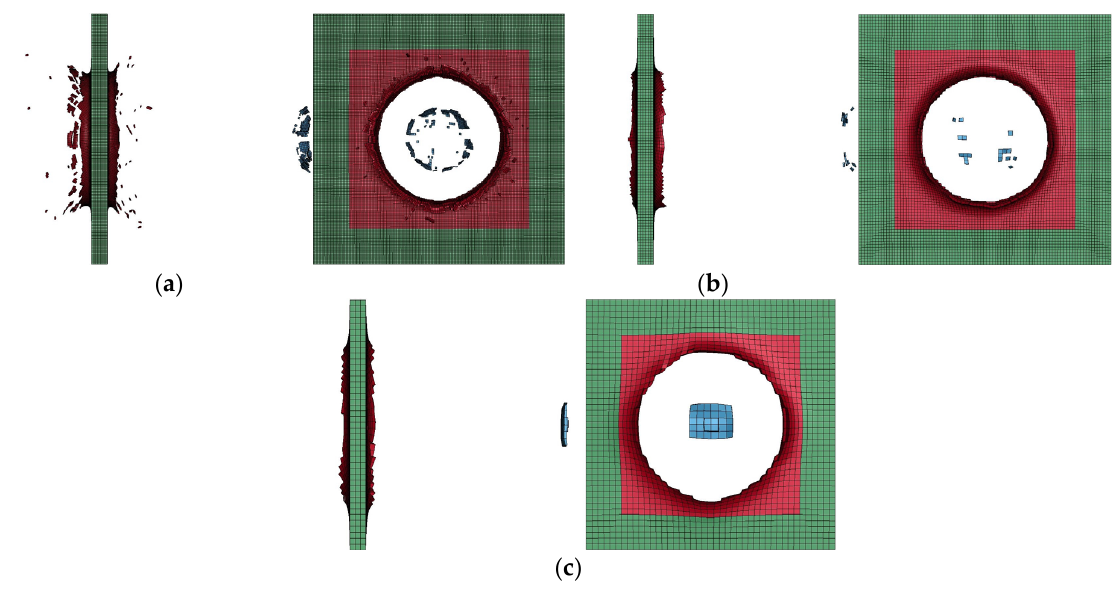
Figure 14. Schematic diagram of the shape and distribution of debris fragments under different mesh